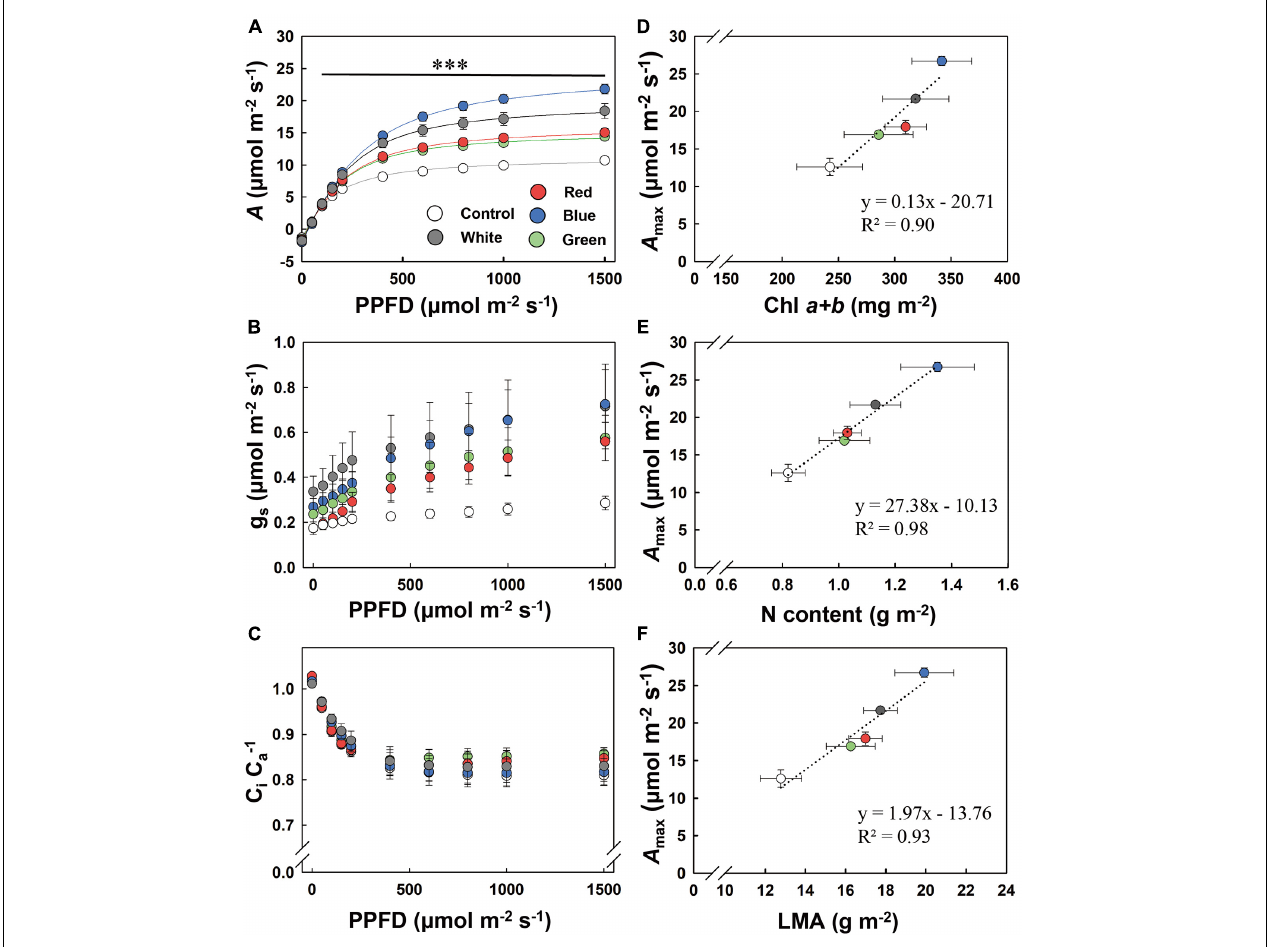
FIGURE 1 | Response of steady-state net leaf photosynthesis ( A ; A ), stomatal conductance (g s ; B ), and leaf internal CO 2 partial pressure relative to that of the air (C i C a − 1 ; C ) to photosynthetic photon flux density (PPFD), and relationship of maximum photosynthesis rate ( A max ) to chlorophyll a and b contents (Chl a + b ; D ), N content per leaf area (N; E ), and leaf mass area (LMA; F ). Control, shade solar light. Mean value ± SEM of 3–4 experimental batches is shown ( n = 3–4), with four to six replicate plants per experimental batch. The asterisks in (A) indicate significant differences between treatments, ∗∗∗ p < 0.001. The dotted line in ( D–F) represents a significant linear regression, with equations and R 2 coefficients